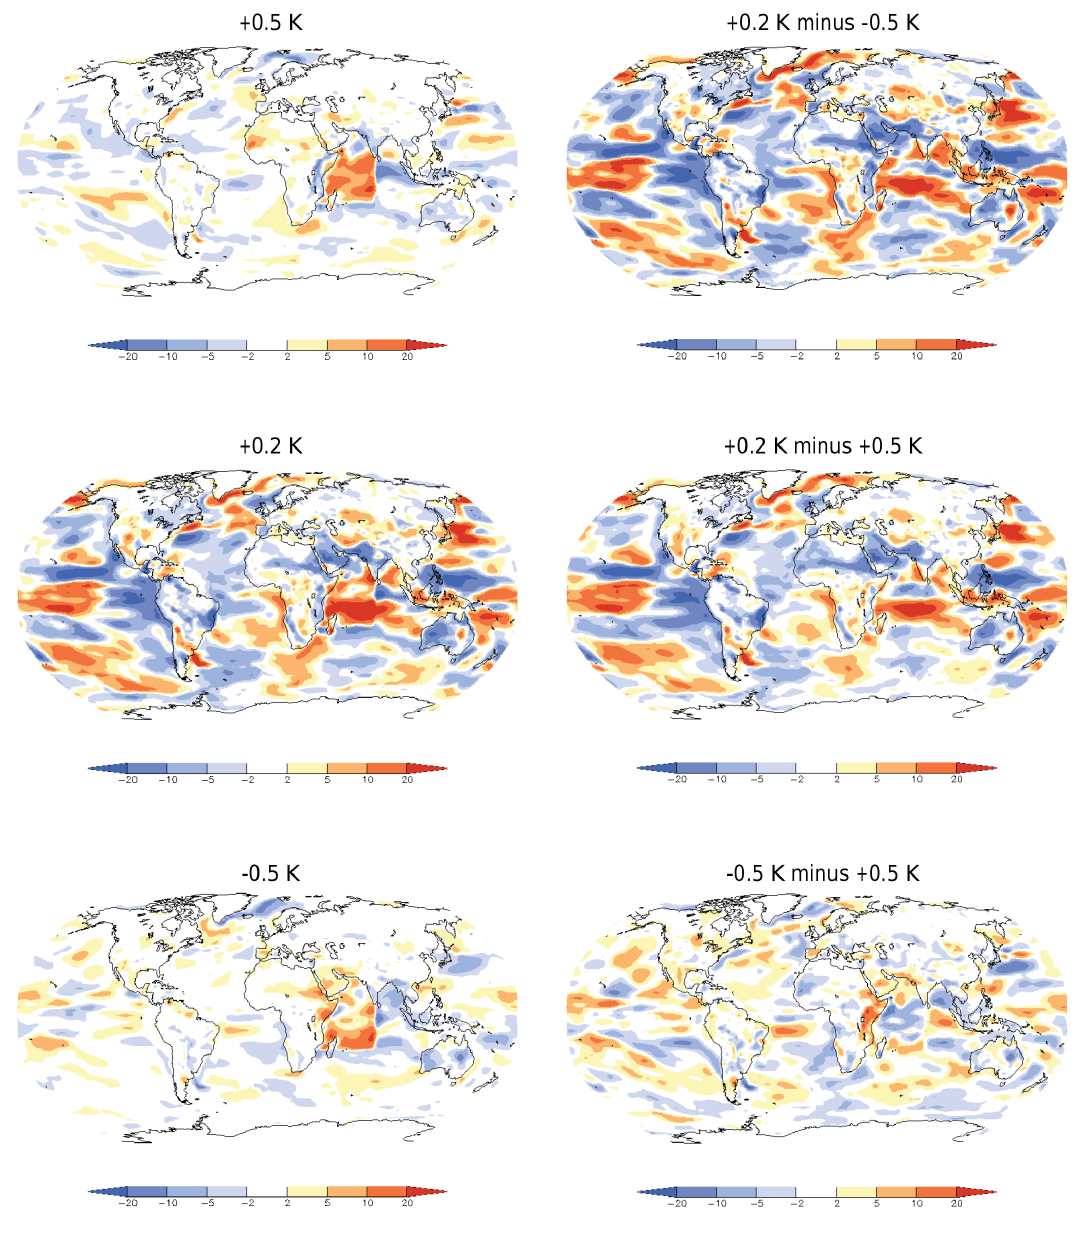
Figure 12. As in Fig. 11 but for latent heat flux sensitivity (Wm − 2 K − 1